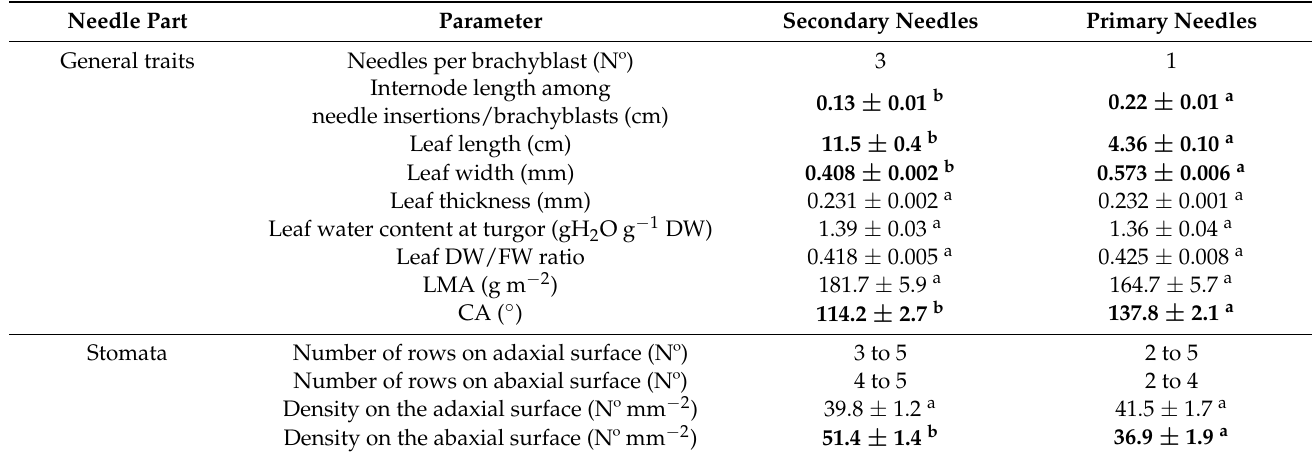
Table 1. Morphological traits of secondary (adult) and primary (juvenile) needles in P. canariensis . Values are mean ± SE ( n = 20, except for leaf water content, dry weight/fresh weight (DW/FW) ratio and leaf mas area (LMA) where n = 9, and contact angle (CA) where n = 16–20). Values highlighted in bold with different letters depict significant differences between secondary (adult) and primary (juvenile) needles ( p < 0.05).